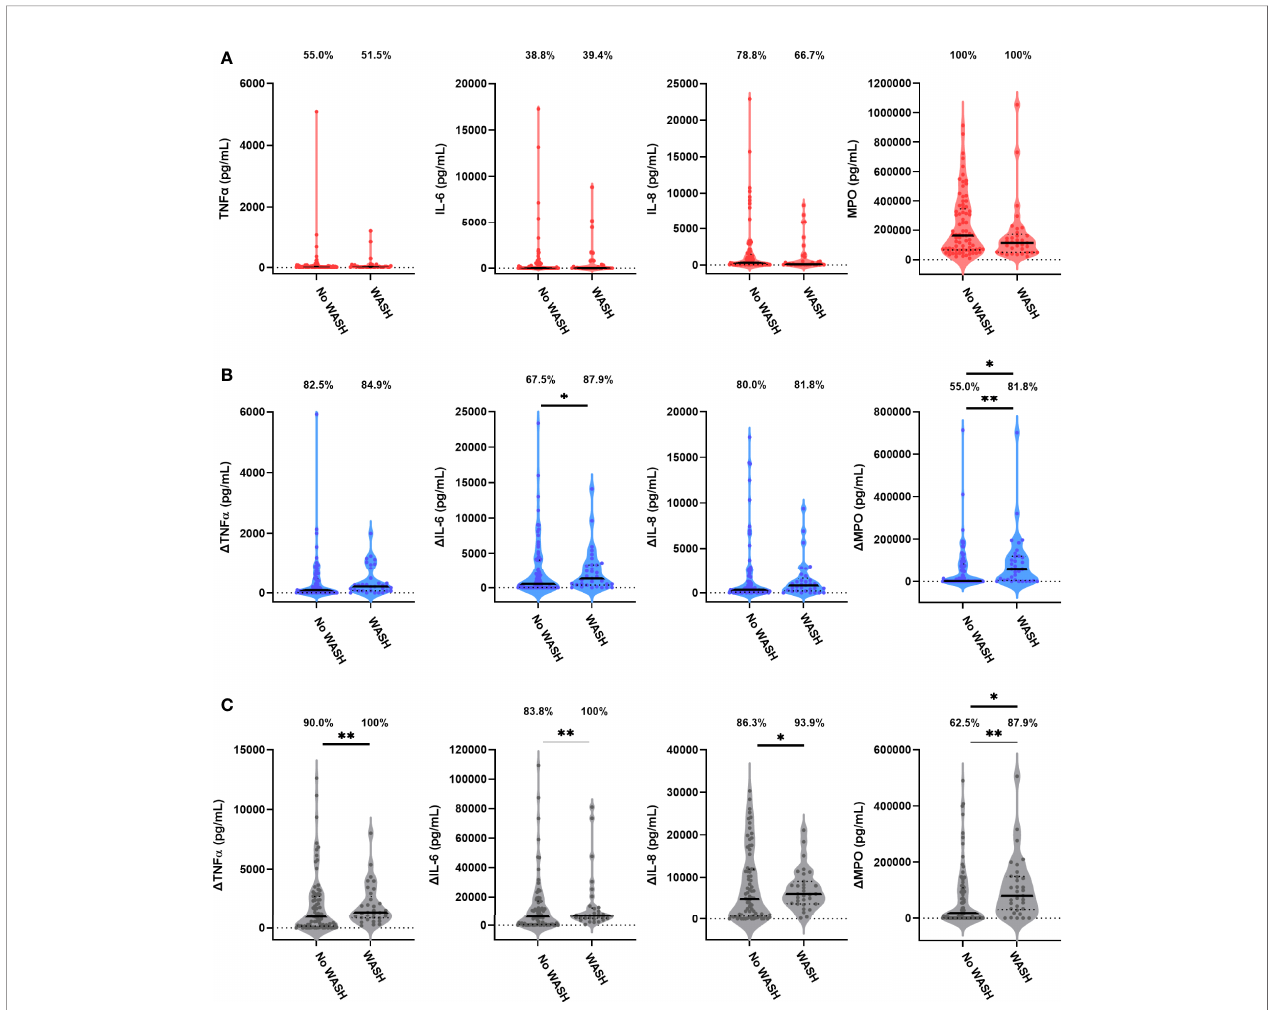
FIGURE 4 | Unstimulated and bacterial antigen-stimulated immune-mediator production by blood immune cells from children exposed versus not exposed to a household WASH intervention. Violin plots (median and interquartile range indicated) of (A) unstimulated (red), (B) LPS-stimulated (blue) and (C) HKST-stimulated (grey) TNF a , IL-6, IL-8 and MPO concentrations in 24h culture supernatants. LPS- and HKST-speci fi c concentrations ( D ) were calculated for each child by subtracting concentrations present in matched unstimulated culture supernatants. Proportions indicate participants with mediator concentration > ELISA limit of detection (A) and participants with antigen-stimulated mediator concentration > unstimulated (B, C) . Proportions of children with detectable mediator levels and mediator concentrations were compared by exposure to the SHINE WASH intervention (WASH n = 33, no WASH n = 80) via multinomial logit regression and censored log-normal (tobit) regression, respectively (unadjusted analyses indicated; full results in Table 4 ); *p < 0.05, **p <